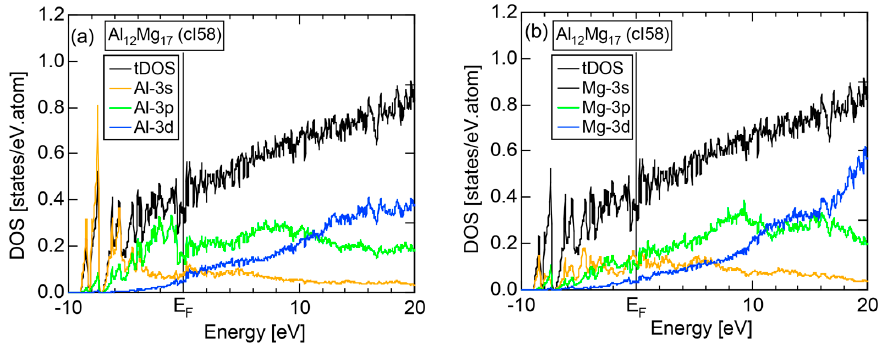
Figure 51. ( a ) Al- and ( b ) Mg-pDOSs along with the total-DOS for Al 12 Mg 17 (cI58).